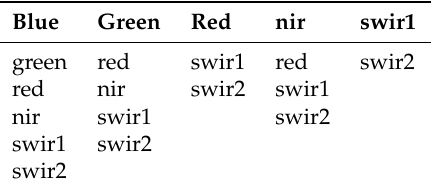
Table 1. Normalized difference metrics (ND; Equation (2)) were calculated for every Landsat-8 and Sentinel-2 image. This table provides an overview of the band